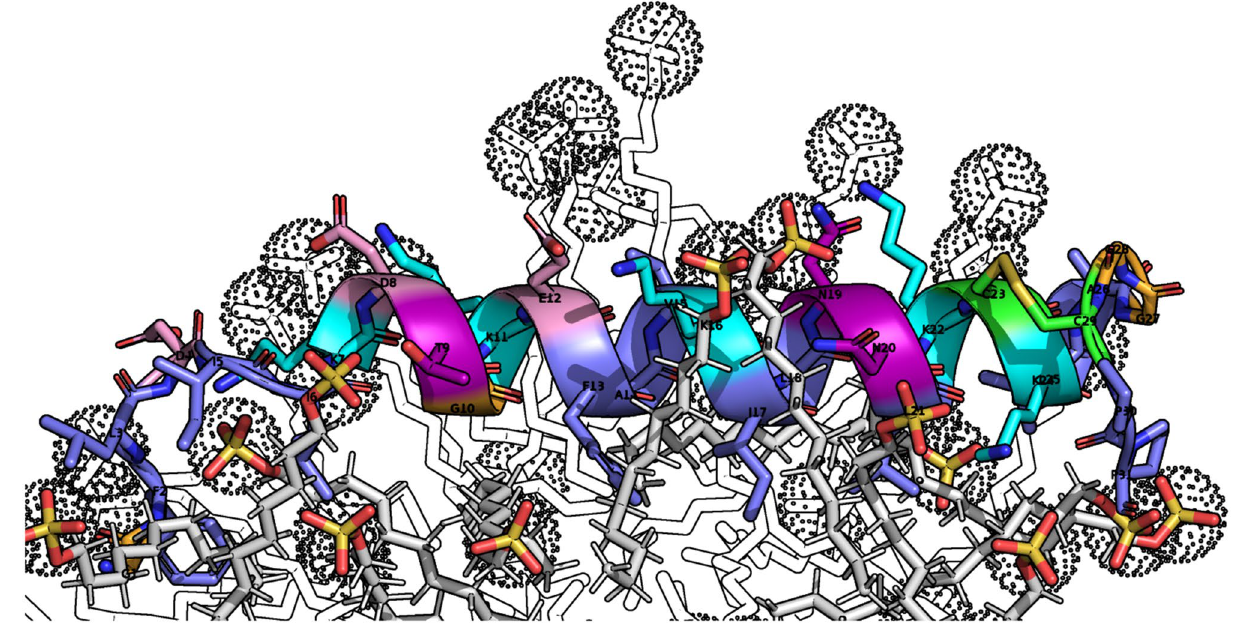
Figure 6. Palustrin-Ca positioned at the SDS micelle-water boundary. Lysine residue side chains are shown interacting with the negatively charged sulfate headgroups. Positively charged residues are coloured in cyan, negatively charged residues are coloured in pink, polar residues are coloured in purple, glycine residues are coloured in orange, cysteine residues are coloured in green, hydrophobic residues are coloured in slate. SDS aliphatic chains are coloured in white, while the SDS headgroups are orange and red, and highlighted with dotted